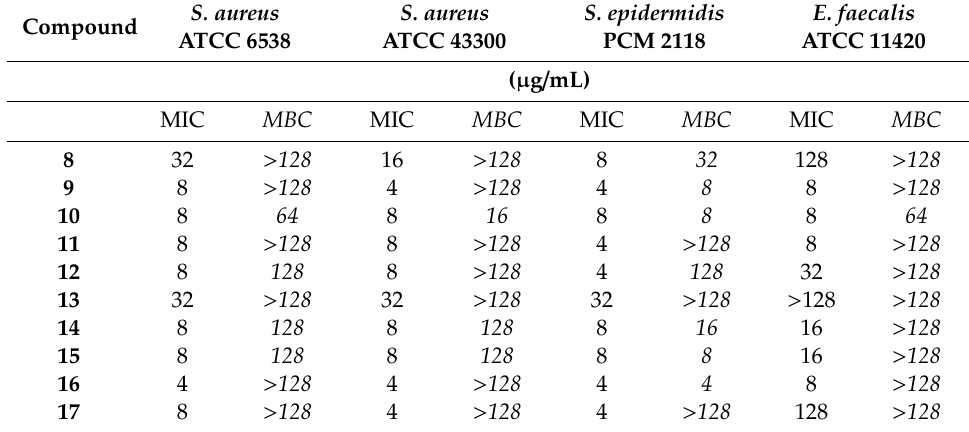
Table 1. Minimal inhibitory concentration (MIC) and minimal bactericidal concentration (MBC) of 8 – 17 against Gram-positive reference bacteria.